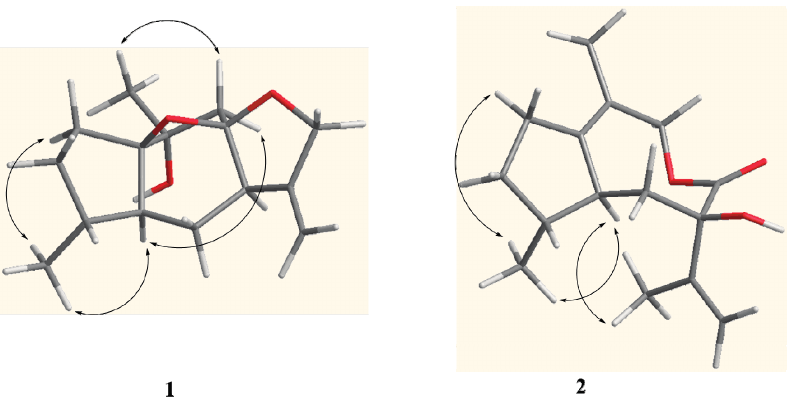
Figure 3. Key ROESY correlations of compounds 1 and 2